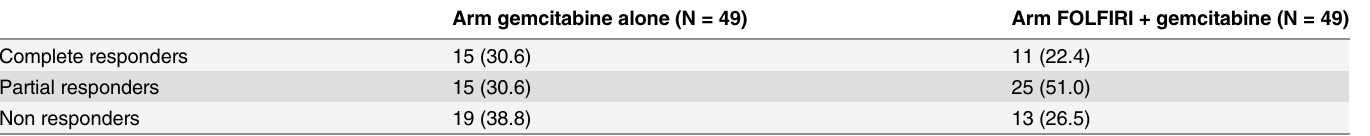
Table 2. Proportion of complete, partial and non responders for HRQoL assessment in each treatment